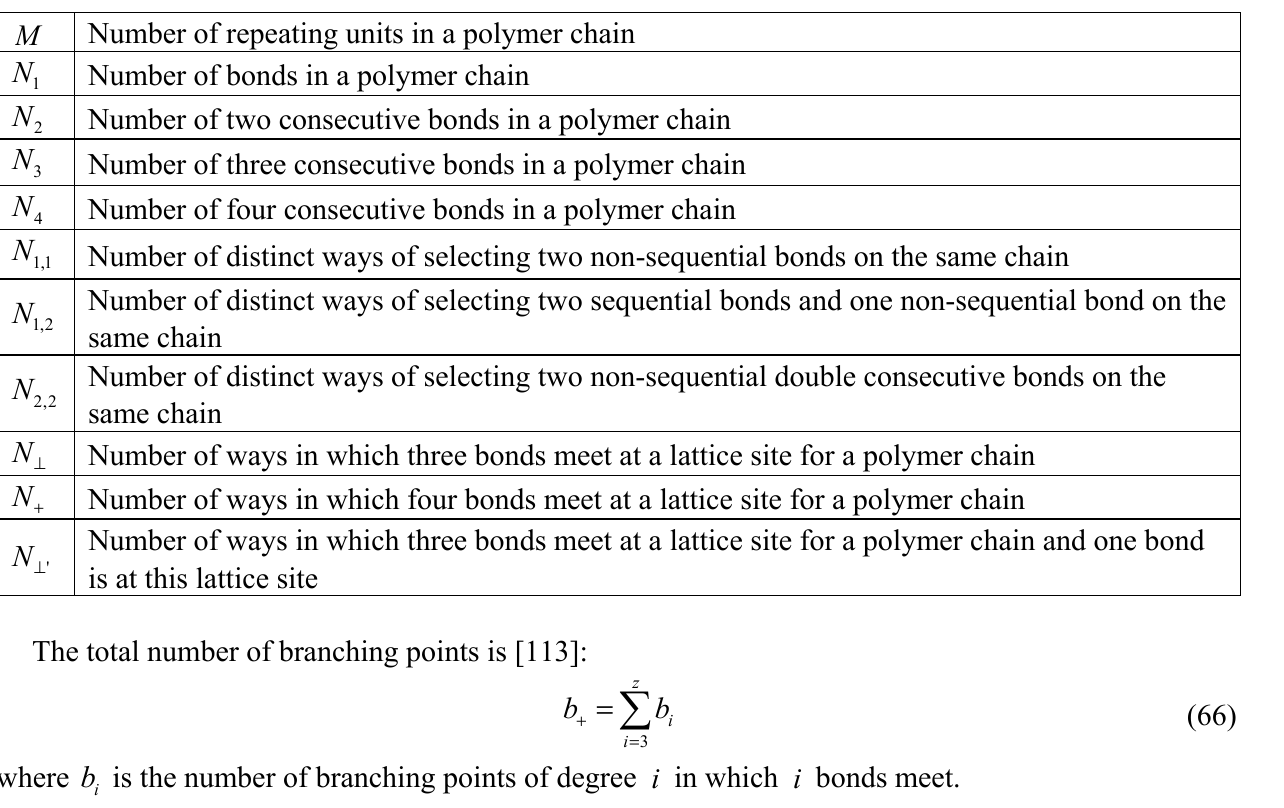
Table 1. Topological coefficients of the LCT for an arbitrary polymer